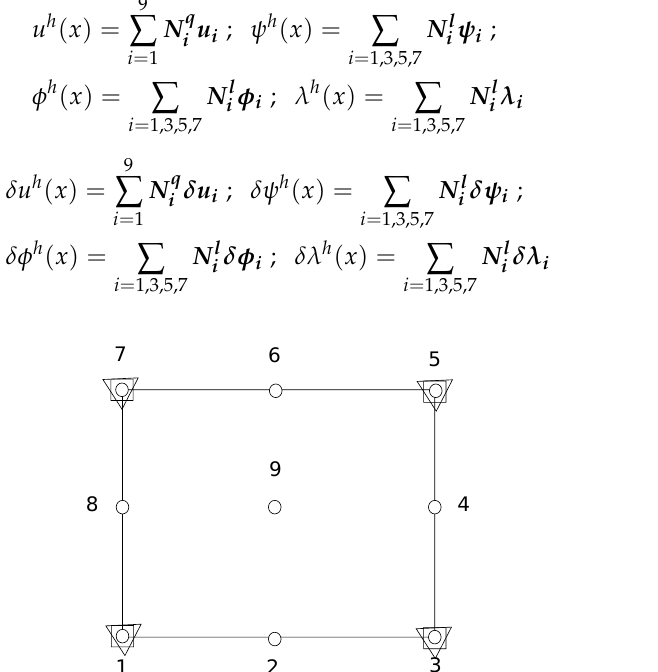
Figure 2. A nine-noded flexoelectric element. DOFs at circles are u 1 and u 2 ; at squares are ψ 11 , ψ 12 , ψ 21 , ψ 22 and φ ; and at triangles are λ 11 , λ 12 , λ 21 , and λ 22